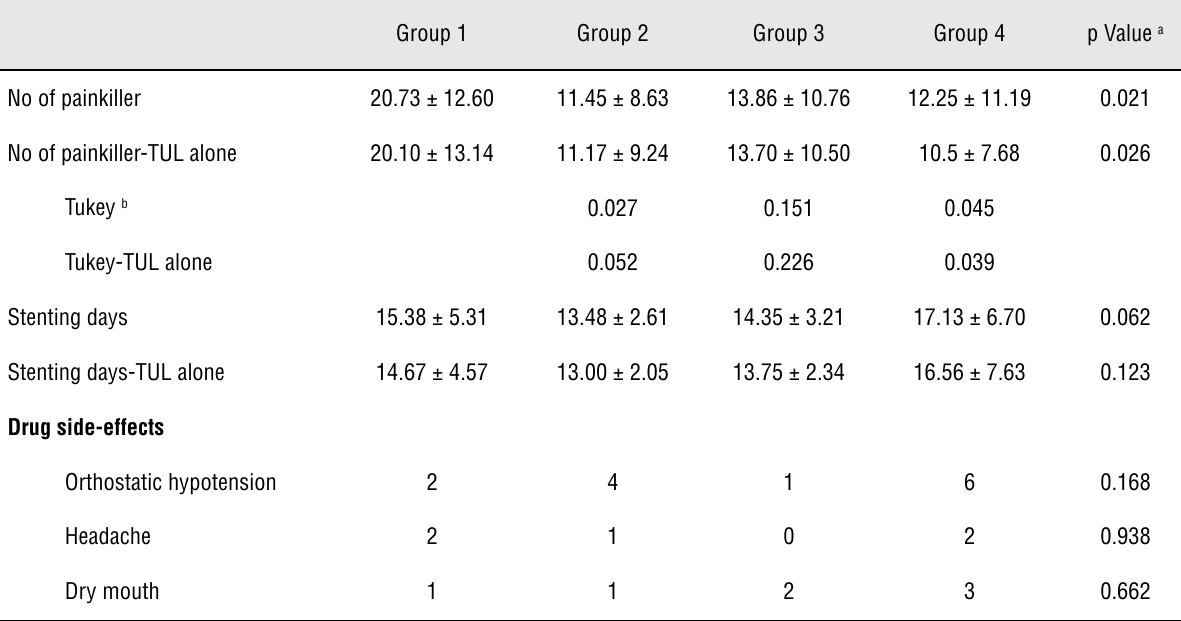
Table 3 - Drug side-effects, narcotics consumption and stenting duration in